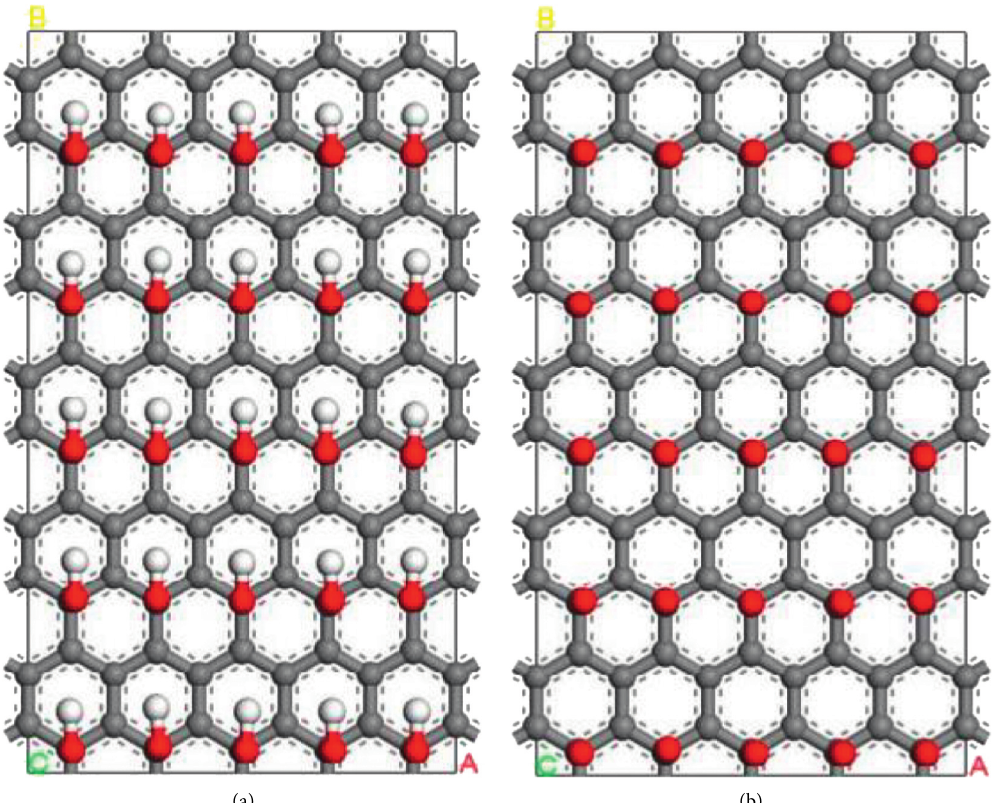
Figure 5: Graphite layer modified by oxygen-containing functional groups: (a) hydroxyl; (b) ketone.